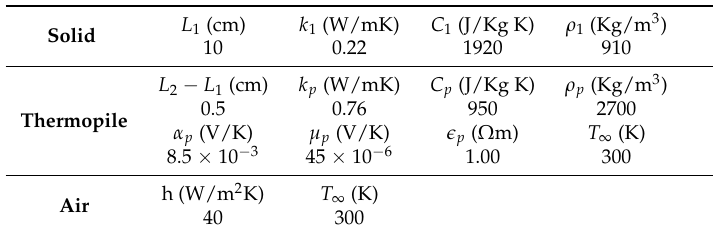
Table 2. Parameter values used in the theory and simulations.